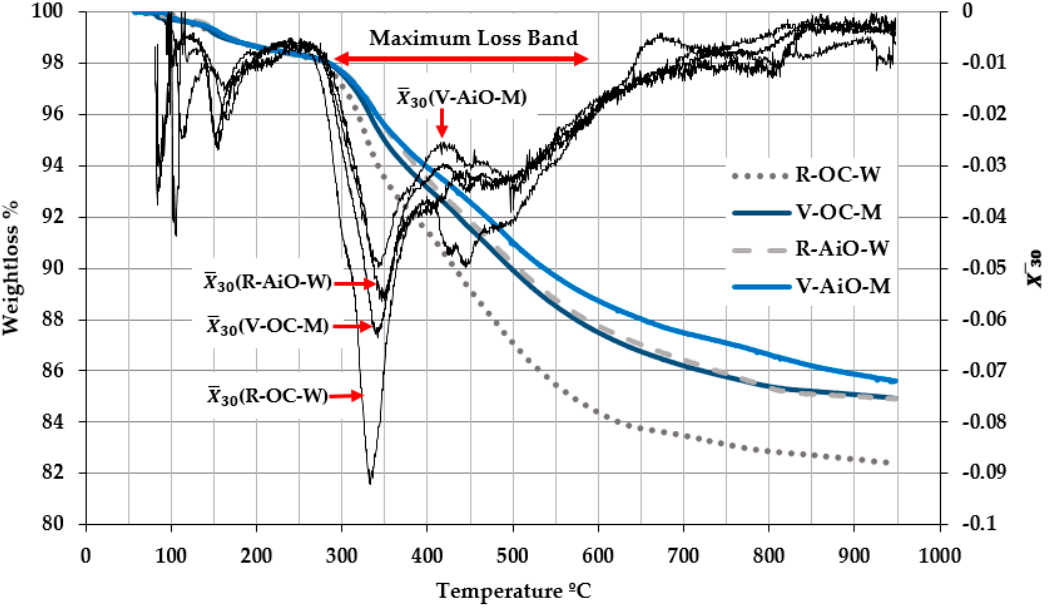
Figure 7. Weight loss vs. temperature increase.